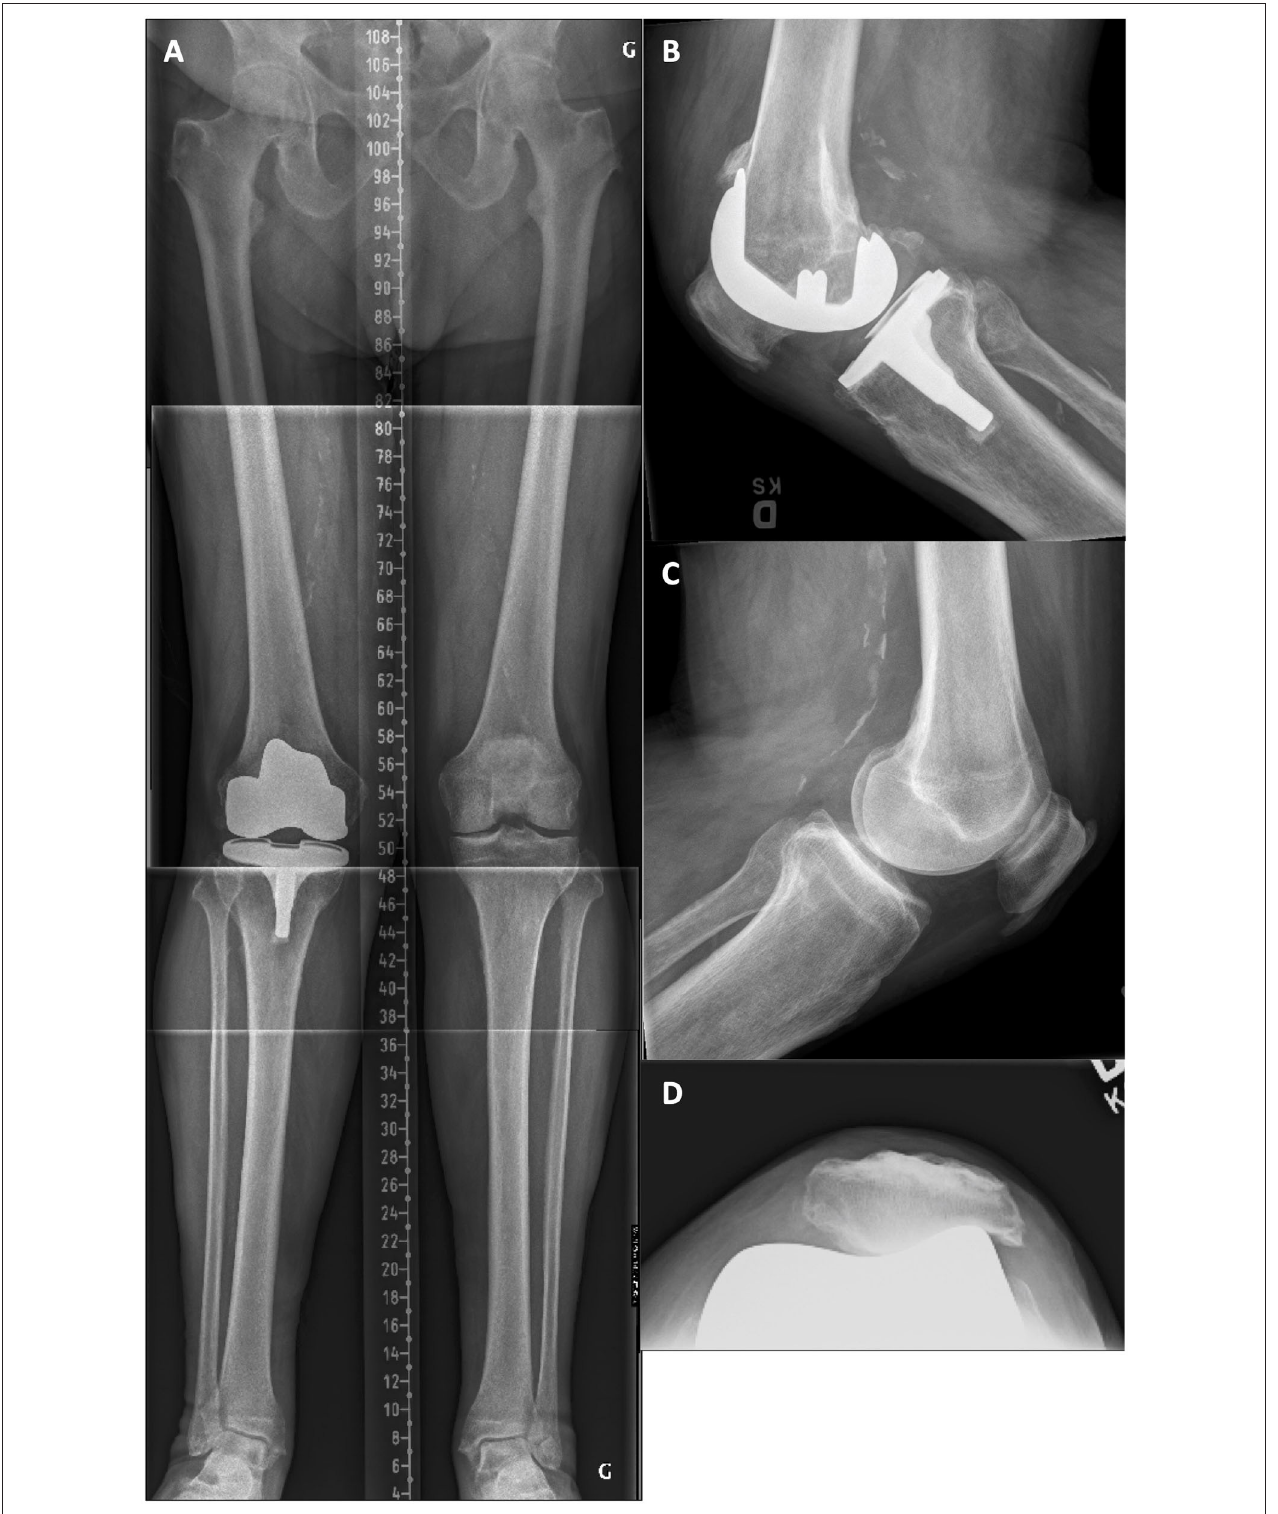
FIGURE 7 | (A) Pre-revision long leg standing X-Ray reveals a right implant mDFA of 4 ◦ valgus and an mPTA of 1.5 ◦ valgus (5.5 ◦ valgus aHKA). On the intact left side, the mDFA is 2.0 ◦ valgus and mPTA 0.5 ◦ varus (aHKA of 1.5 ◦ valgus). (B) Right knee lateral view where the implant tibial slope is 1.5 ◦ anterior. (C) Left knee lateral view where the native tibial slope is 8.0 ◦ posterior. (D) Right knee skyline view showing a subluxed and worn patella.